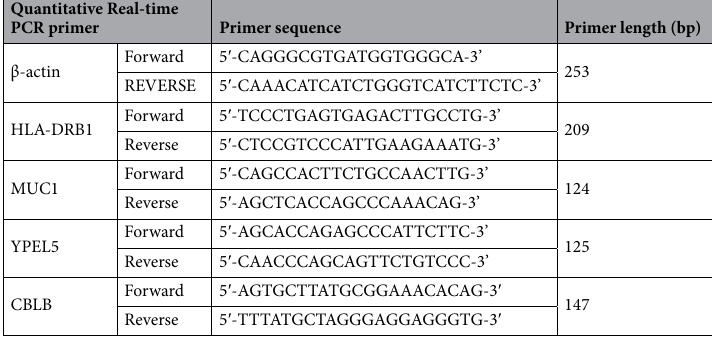
Quantitative Real-time PCR primer Primer